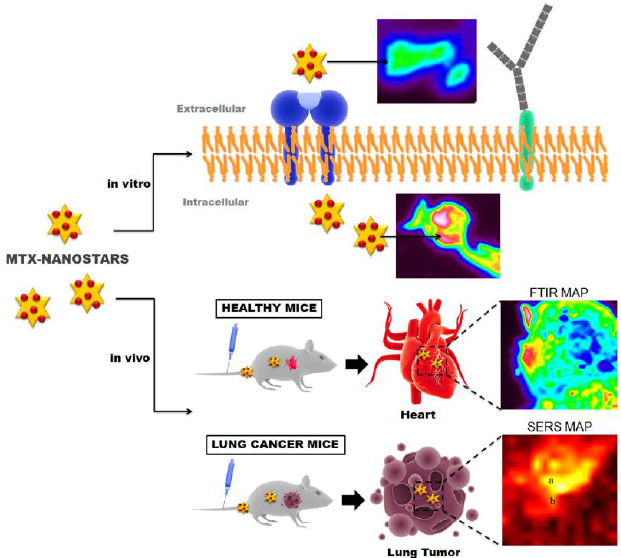
Figure 4. Illustration of the use of mitoxantrone (MTX) nanostars for in vitro and in vivo imaging, as well as nonspecific therapy for patients with cardiovascular diseases. Reprinted from Ref. [84] Copyright (2016), with permission from Elsevier.